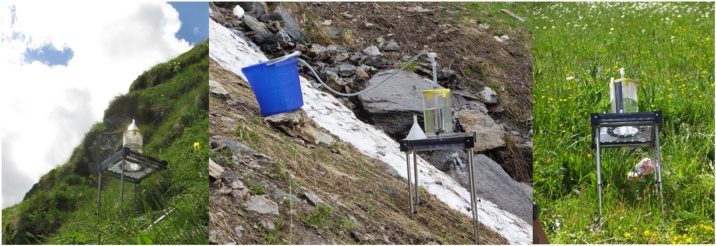
Different set ups and preconditions of the rainfall simulation experiment on steep slopes in Val Piora, Ticino, Switzerland.